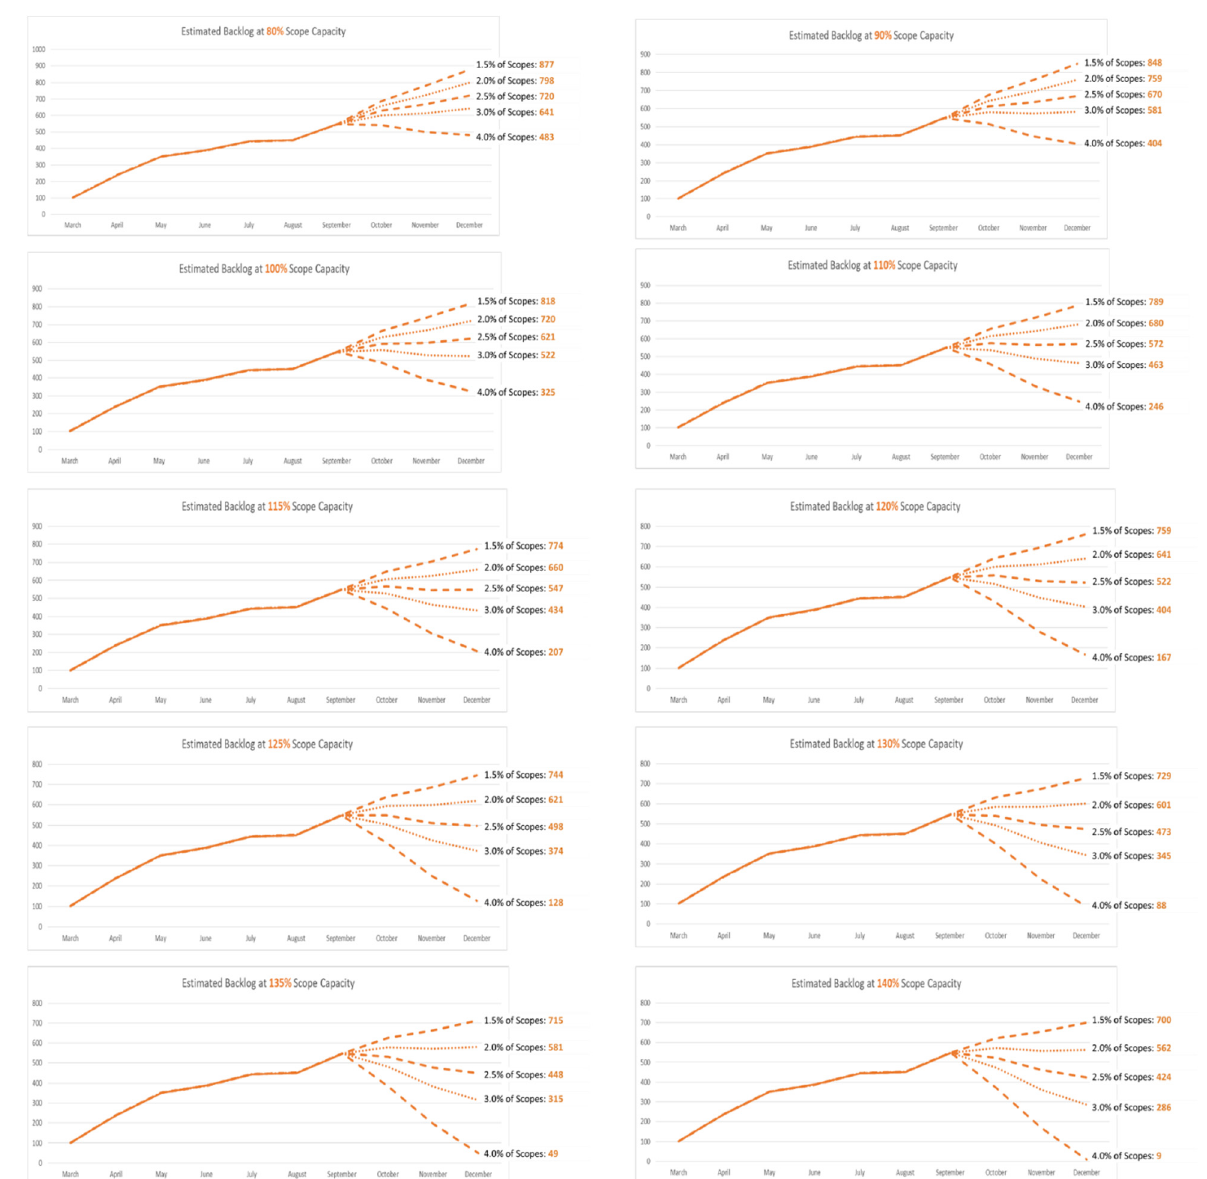
Figure 4. Estimated backlog in CRC diagnoses over the remaining months of 2020 (September–December) under different scenarios defined by monthly colonoscopy capacity and colorectal cancer diagnosis yield.